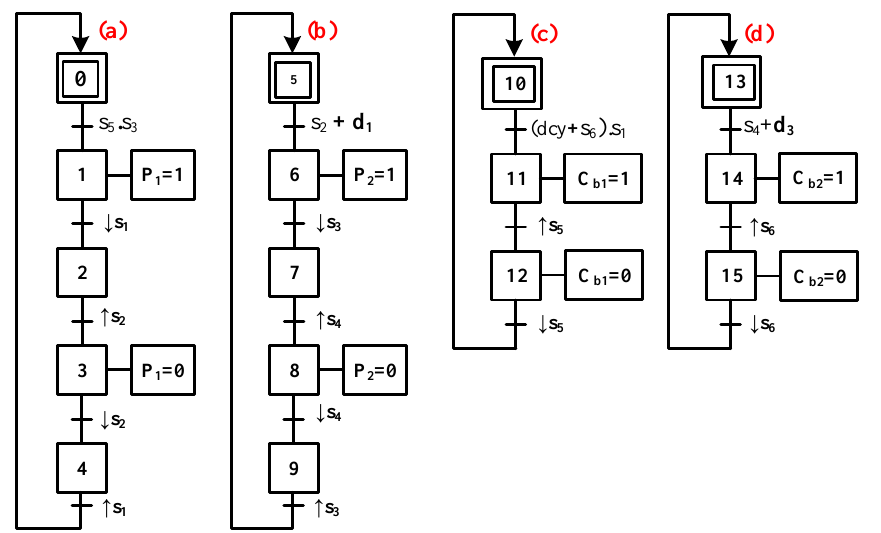
Figure 14. Normal behavior grafcets of ( a ) P1, ( b ) P2, ( c ) C b1 , ( d ) C b2.